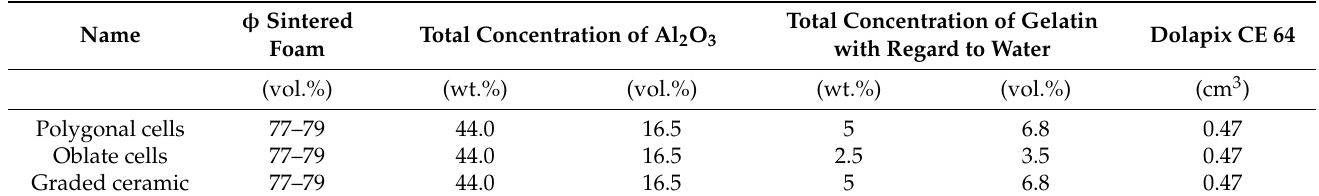
Table 1. Concentration of the solid loading of Al 2 O 3 and gelatin of the water-based alumina suspensions.